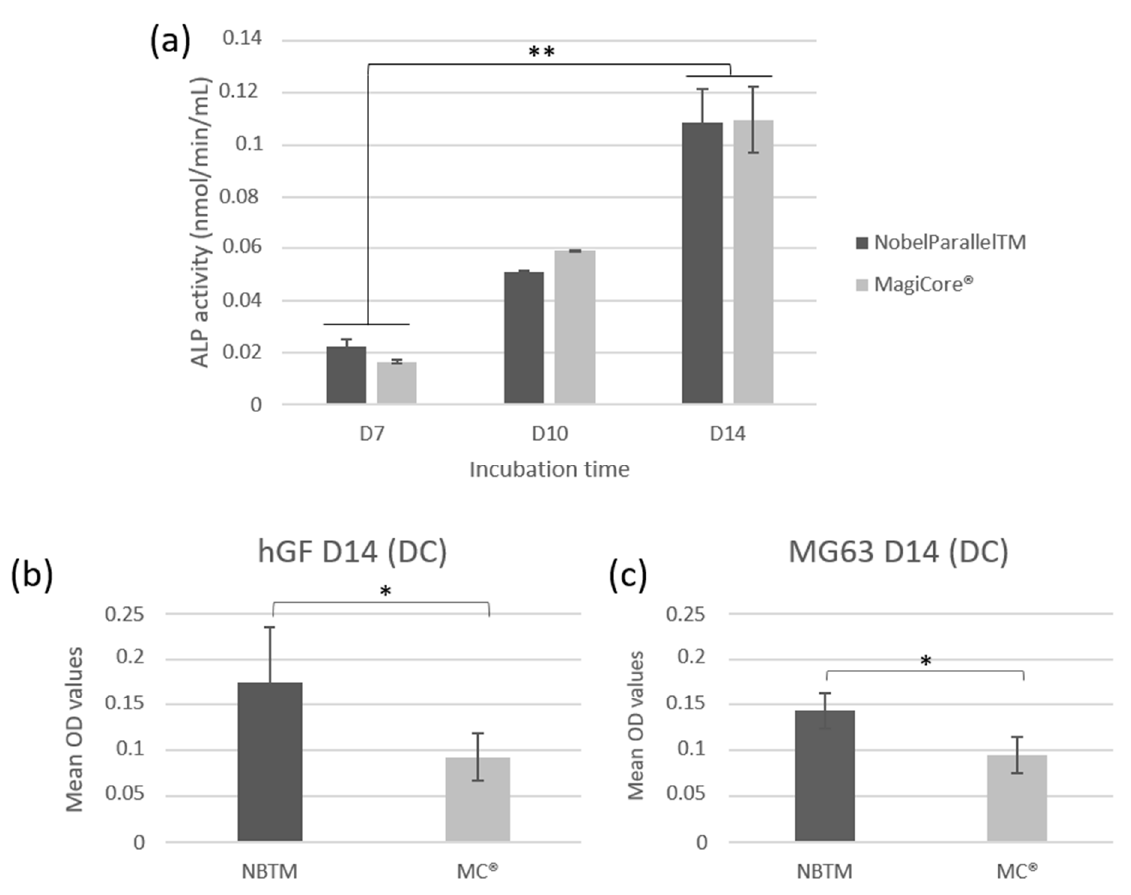
Figure 8. Cellular mineralization: ( a ) extracellular ALP activity of hGF cells following contact with the implants (n = 7 ± SD, ** p < 0.01). Quantification of calcium deposition of cells using alizarin red staining on ( b ) hGF and ( c ) MG63 cells (n = 7 ± SD, * p < 0.05).